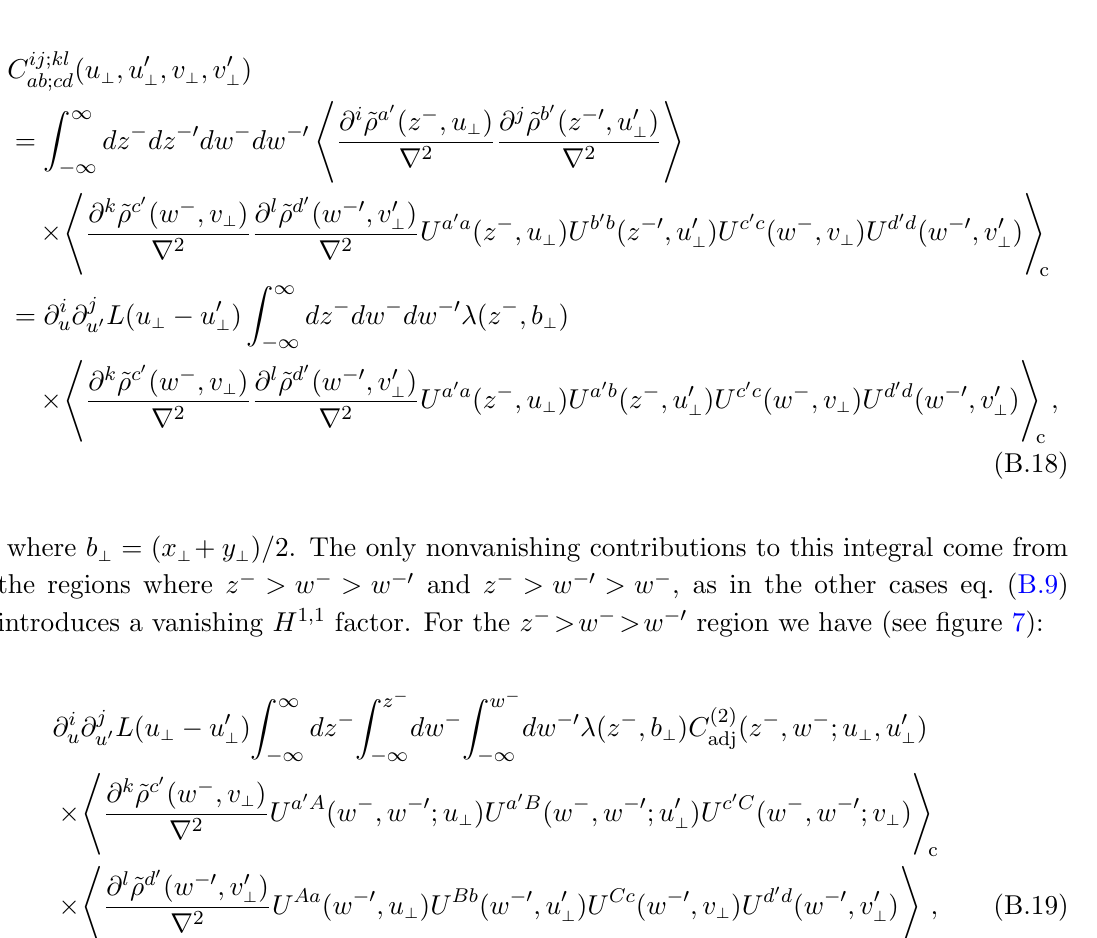
which vanishes due to the antisymmetric property of the SU( N c ) structure constants. As we have the same contribution from every region of the integration space, eq. (B.15) yields